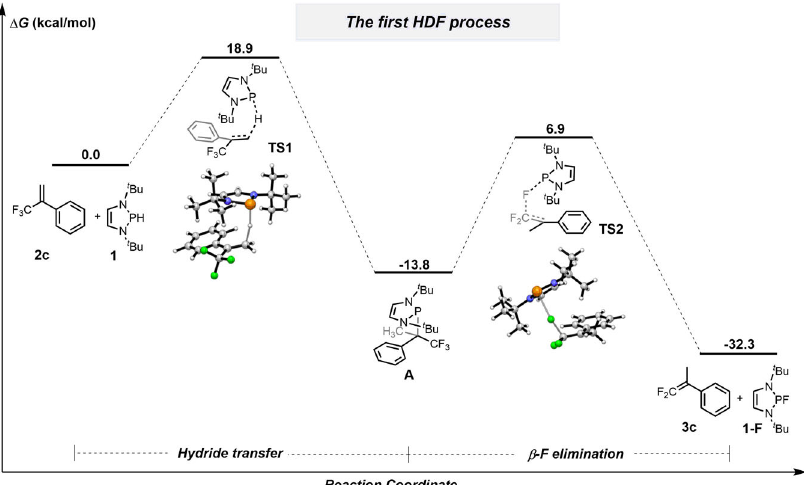
Fig. 7 Mechanistic investigations for the fi rst HDF process by DFT calculations. Energy pro fi les for mono-HDF of 2c by 1 in acetonitrile calculated at the